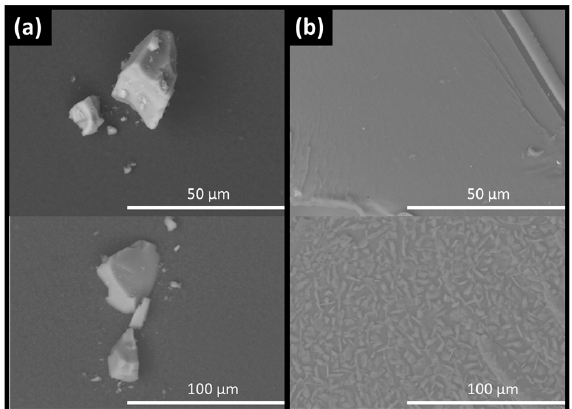
Figure3. SEMimagesforhaloperidolloadedsilica( a )andHME( b )showingparticlesizeandmorphology at 0 days (top) and 90 days stability (bottom) as specified in the materials and methods